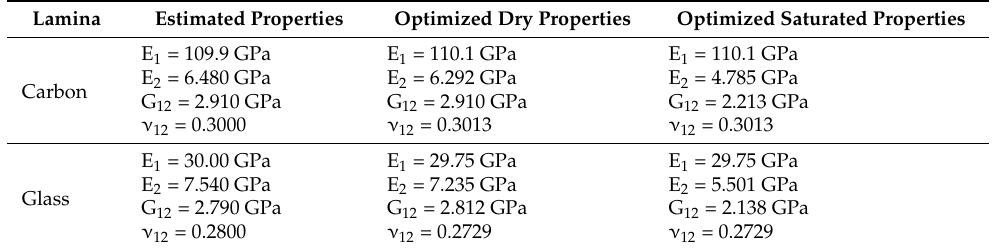
pared with initially estimated values from the RVE model using published fiber and matrix properties.